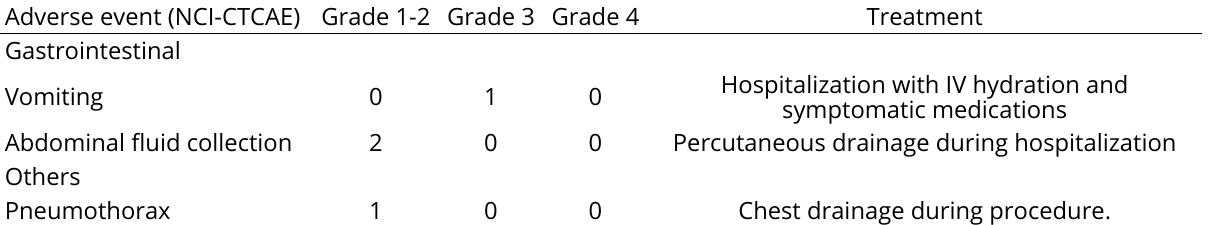
Table 4. Adverse